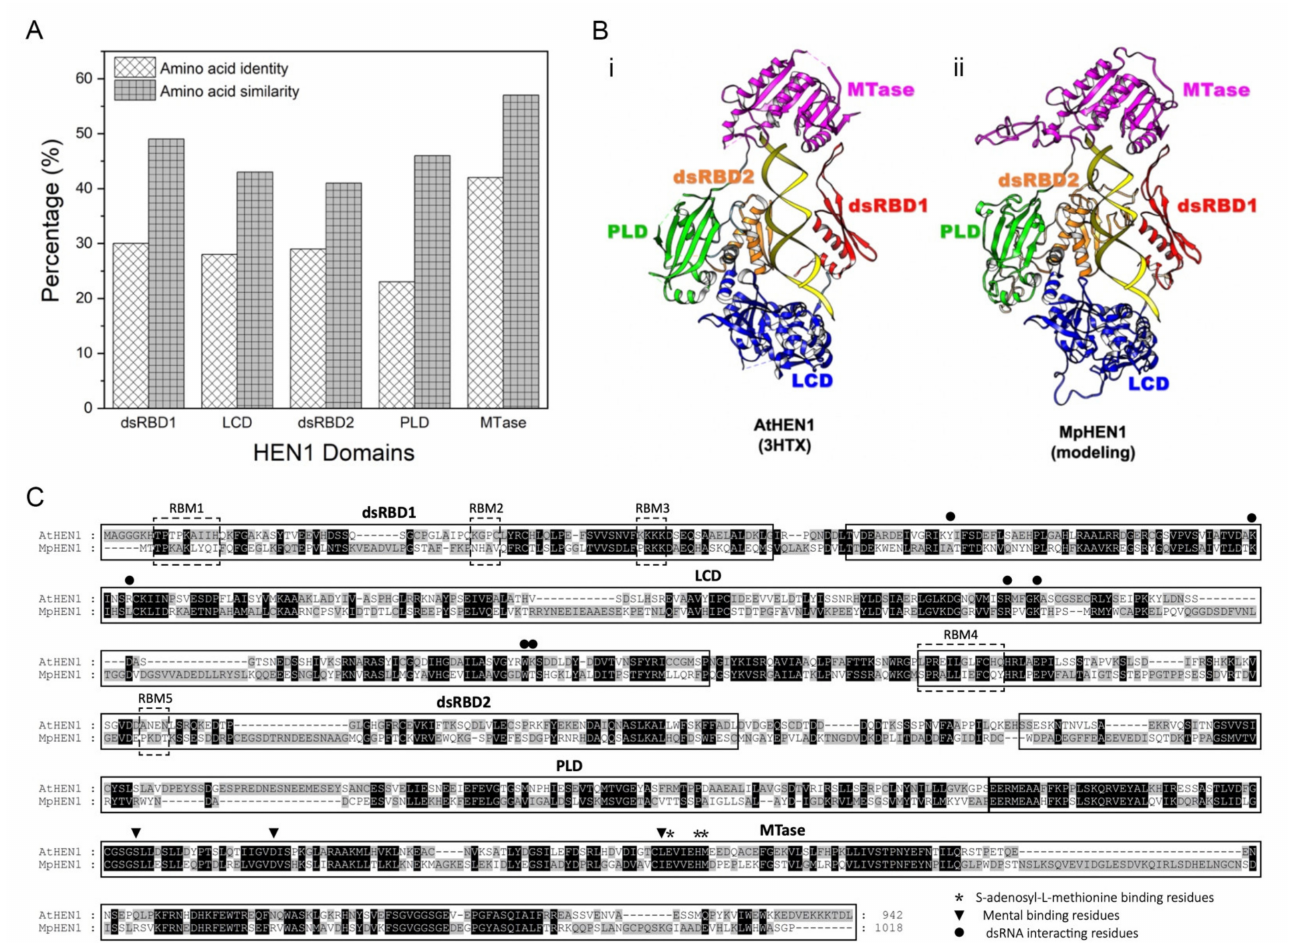
Figure 7. AtHEN1 and MpHEN1 structural analysis. ( A ) The domain comparison between AtHEN1 and MpHEN1. The Y-axis represents the percentage of similarity and identity. The X-axis represents the domains of HEN1. ( B ) Structural comparison between (i) AtHEN1 and (ii) MpHEN1 model. The dsRBD1, LCD, dsRBD2, PLD, and MTase domains on the AtHEN1 (PDB number: 3HTX) and MpHEN1 models are highlighted by red, blue, orange, green, and magenta, respectively. ( C ) Amino acid sequence alignment for AtHEN1 and MpHEN1. The five domains are highlighted by a box based on AtHEN1 structure studies and compared with the MpHEN1 sequence. The arrowheads, asterisks, and dots indicate the SAM-binding residues, metal-binding residues, and double-stranded RNA-interacting residues,